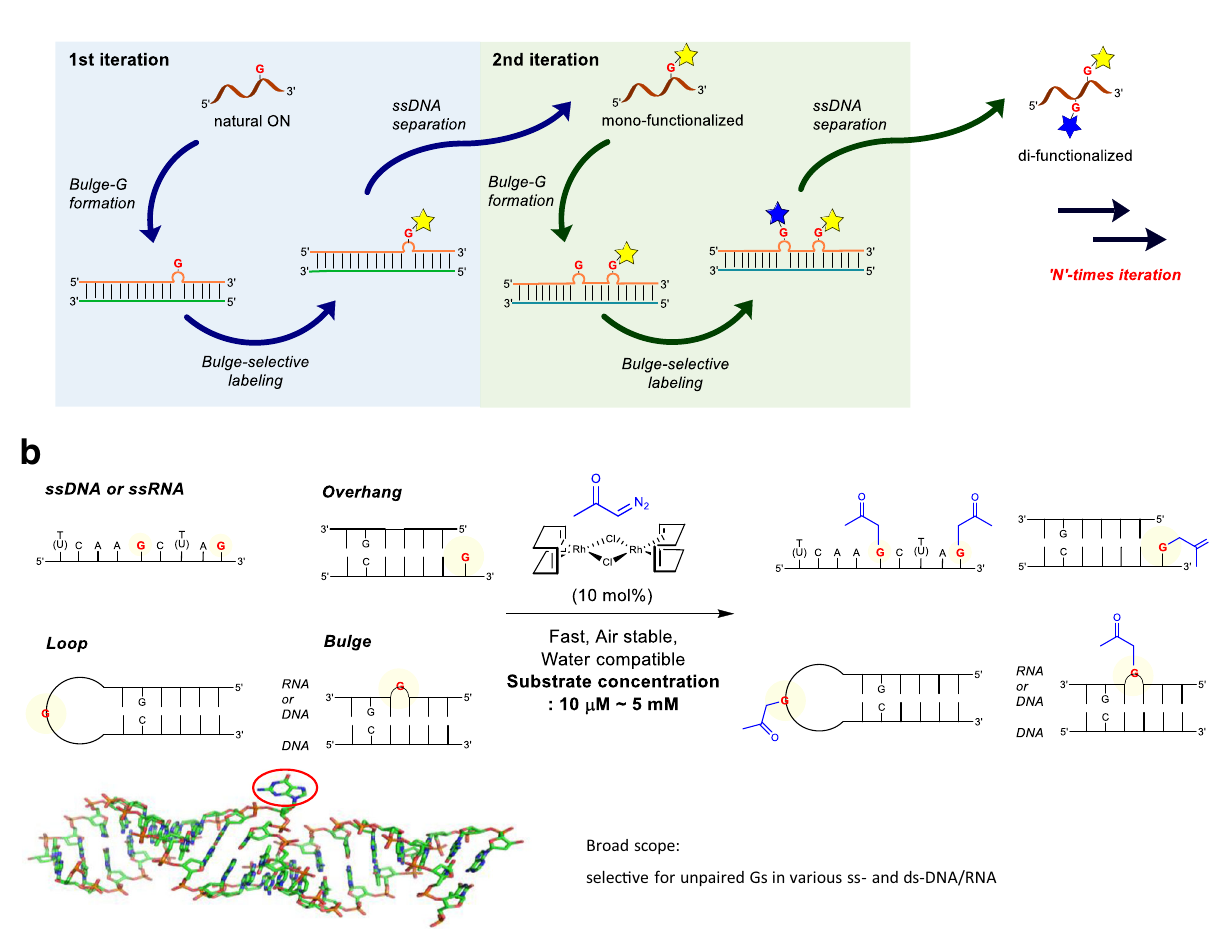
Fig. 1 Site-selective modi fi cation of oligonucleotides. a Iterative functionalization of oligonucleotides. b Compatibility with various secondary structures in a wide range of concentrations; 3D model of bulge-guanosine (G) dsDNA.